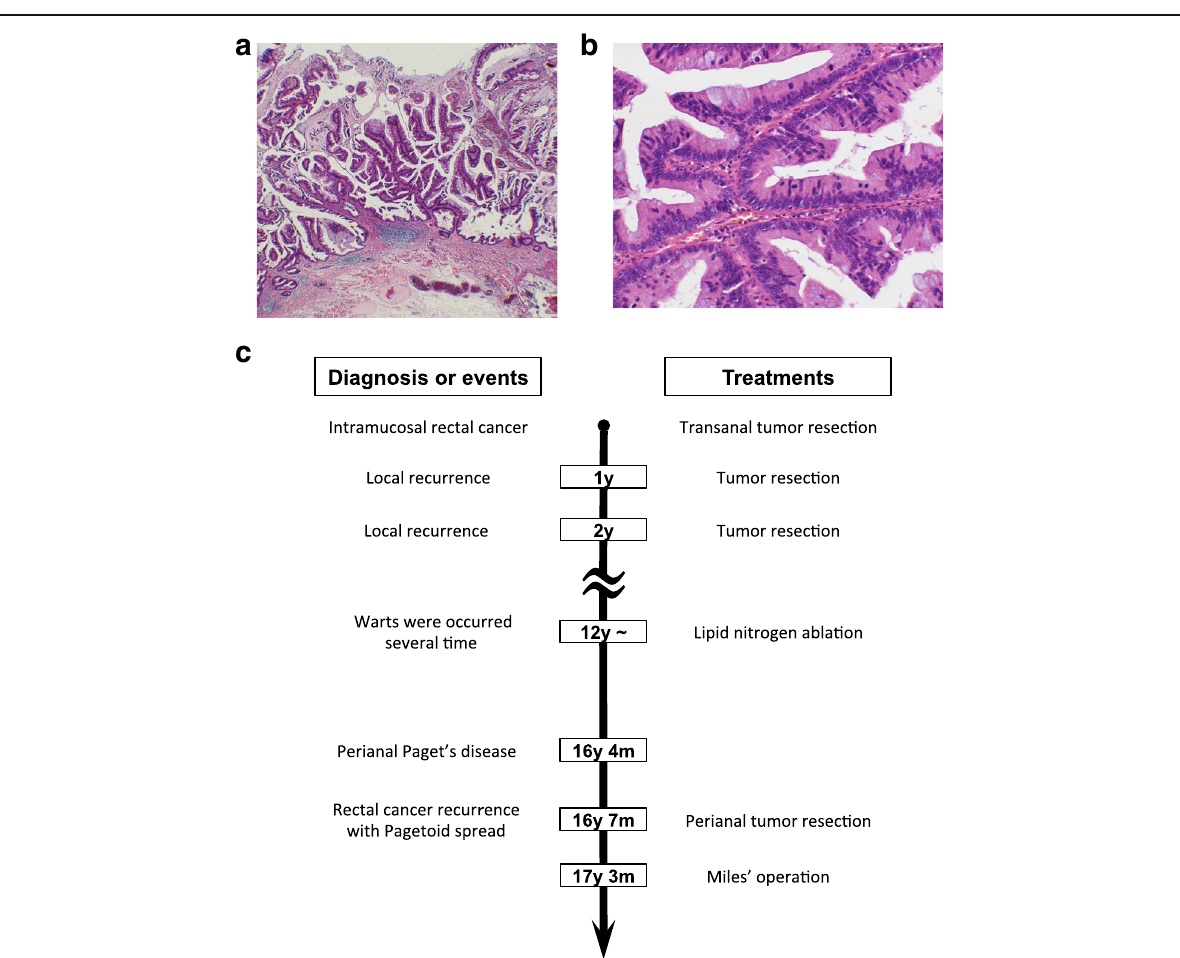
Fig. 1 The pathological features of specimen resected after the first operation. The tumor was seen in the intramucosal layer ( a ) (HE, ×20), which was well-differentiated adenocarcinoma ( b ) (HE, ×200). Schematic summary of the patient ’ s long-term clinical history. HE hematoxylin and eosin ( c